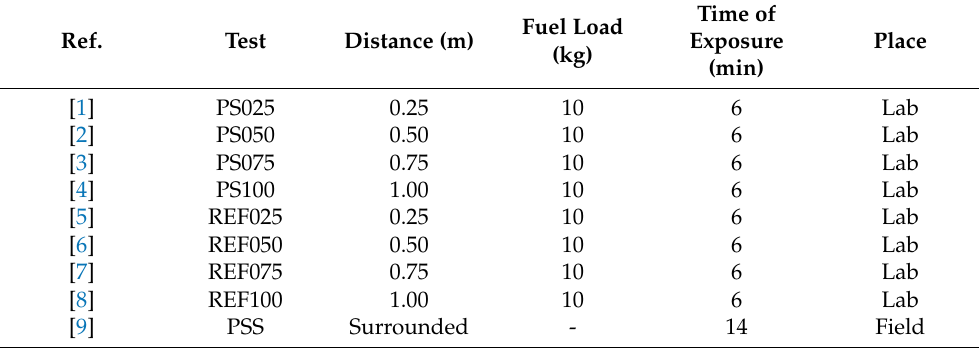
Table 1. Summary of the performed tests.